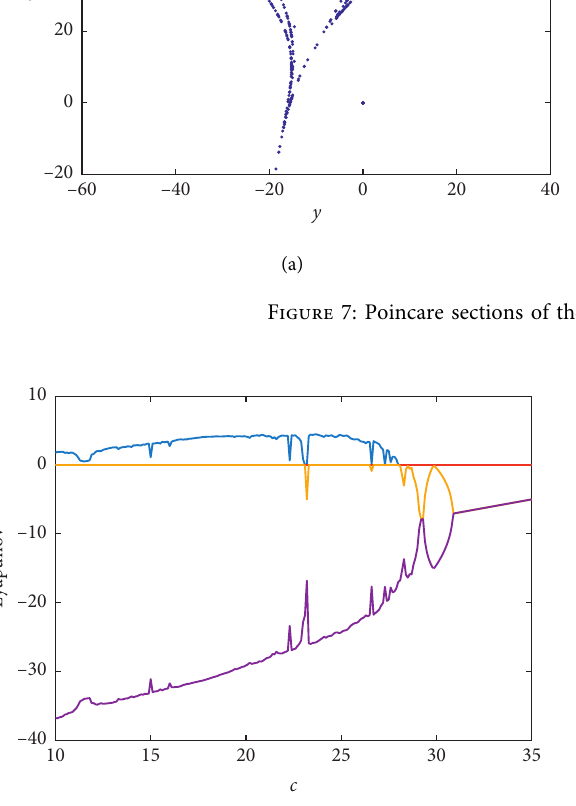
Figure 8: Lyapunov exponent spectrum corresponding to c .